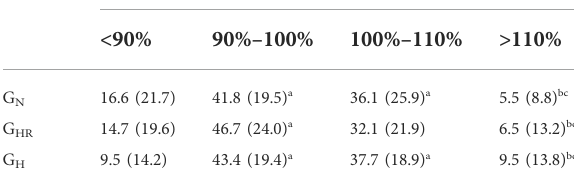
TABLE 6 Set percentage in each training zone according to lactate concentration ([La − ]) over the 8 weeks of intervention. AT2